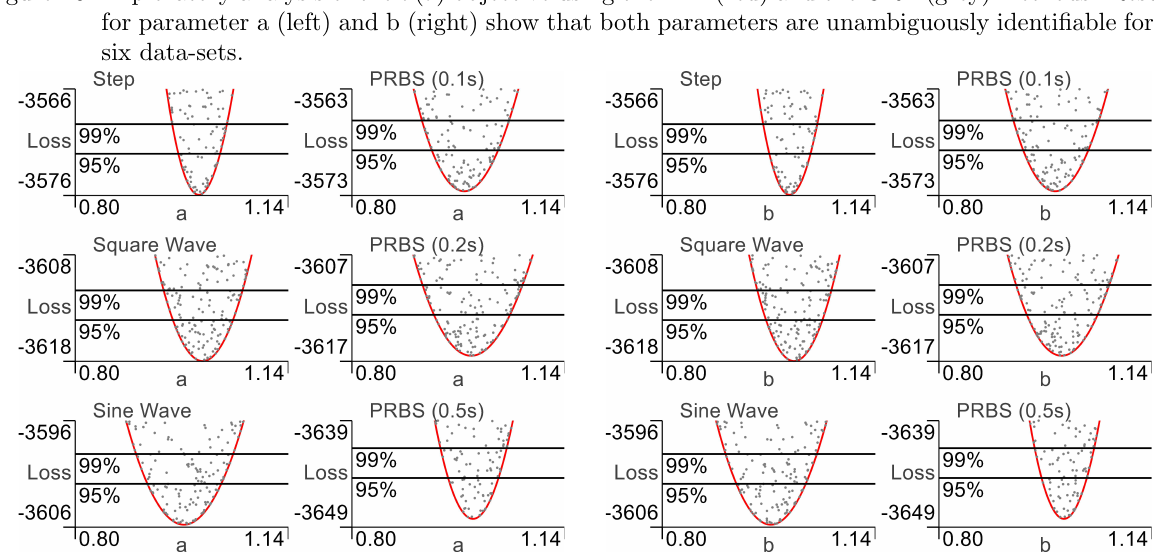
Figure 11: PL1 and URP results, zoomed in around the optimum, for parameter a (left) and b (right). files/intervals, as discussed in Section